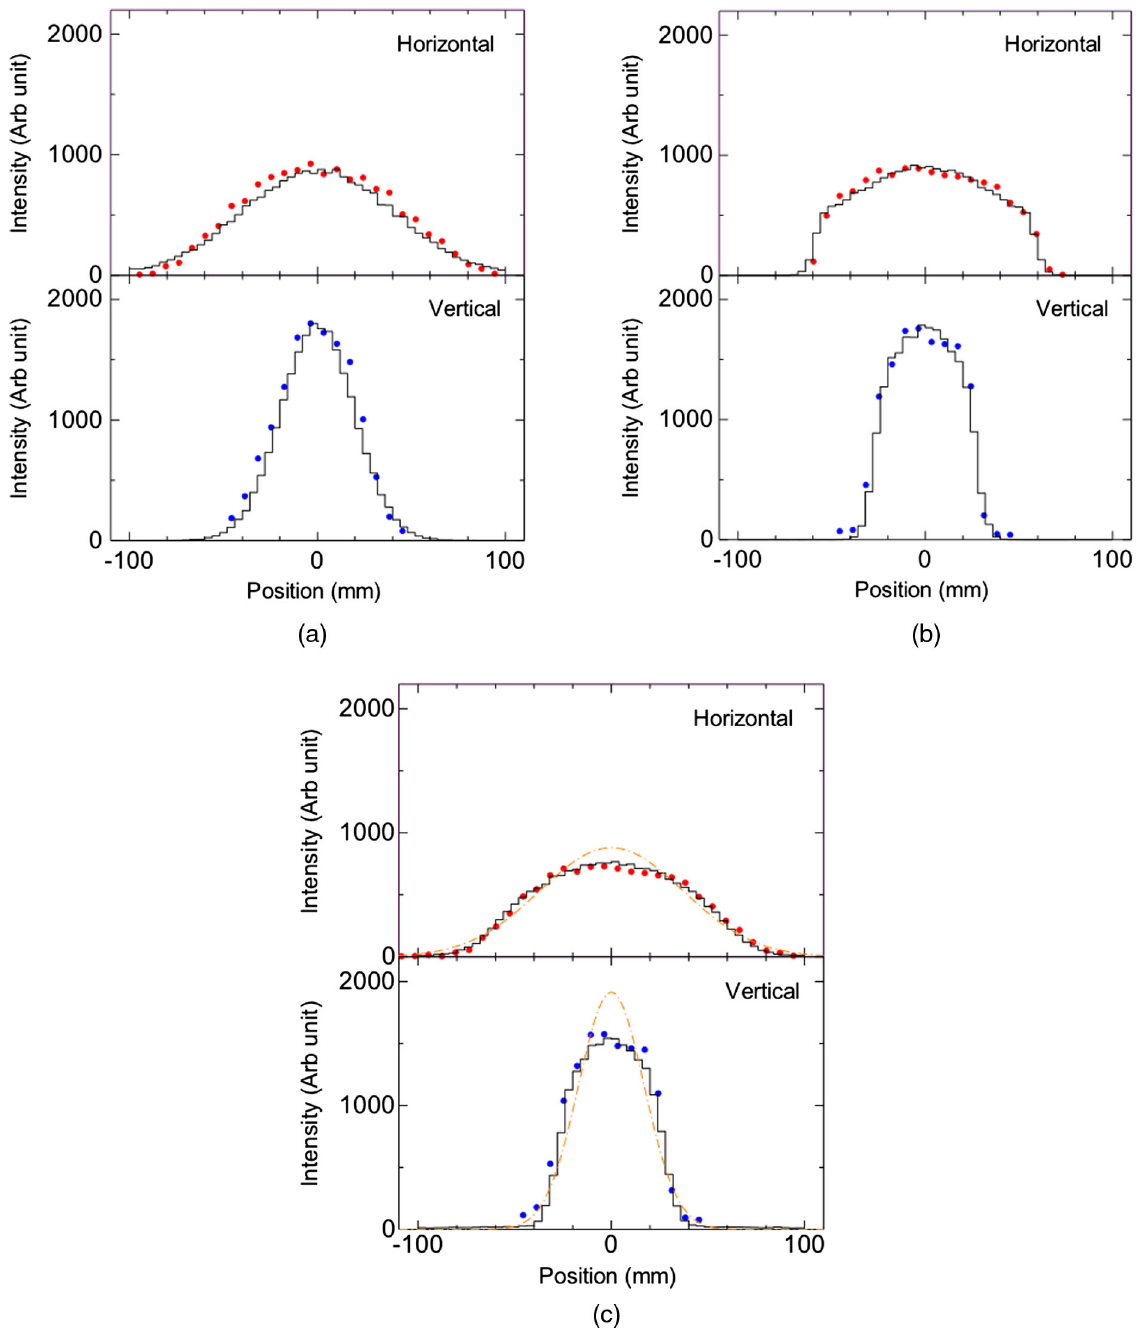
FIG. 14. Beam profile of 1-MW beam obtained with MWPM placed at PBW in the horizontal and vertical planes shown at the top and bottom, respectively, where (a) and (b) show the results for the cases of linear and nonlinear optics with current of 698 A supplied to the octupole magnet, and comparison with the calculation result obtained with tracking using SAD . Panel (c) shows the result for nonlinear optics placing with the muon production target compared with simulation scattering effect by DECAY - TURTLE [50] and compared with the linear optics result (dotted orange line) allowable for beam